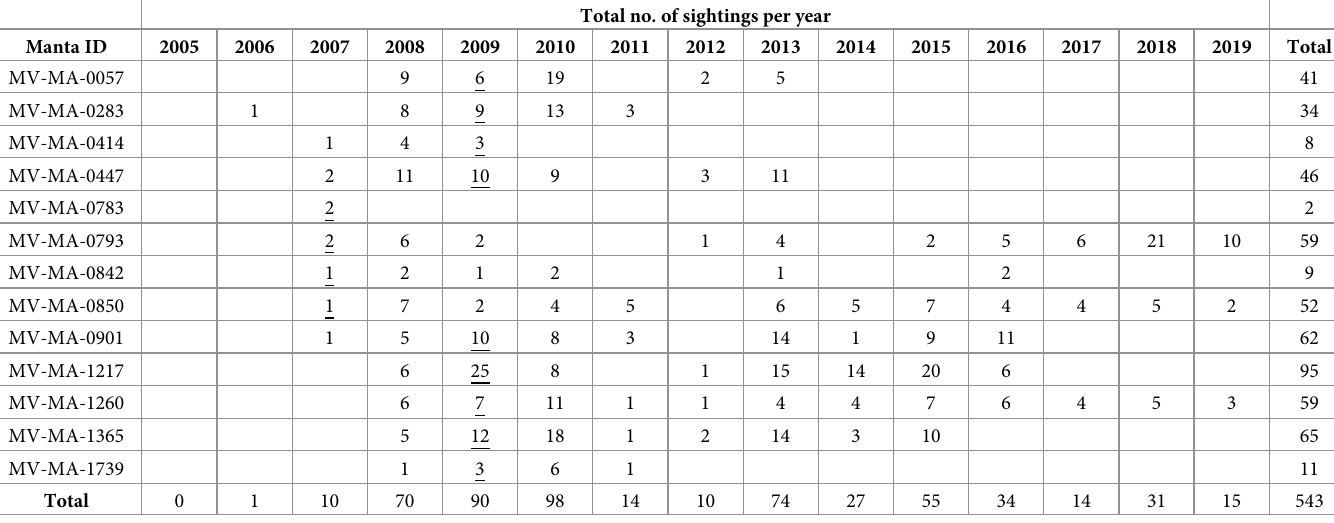
term M . alfredi visitation trends and small-scale movement patterns to key habitat, Table 5. Summary of tagged manta photo identification records from the key